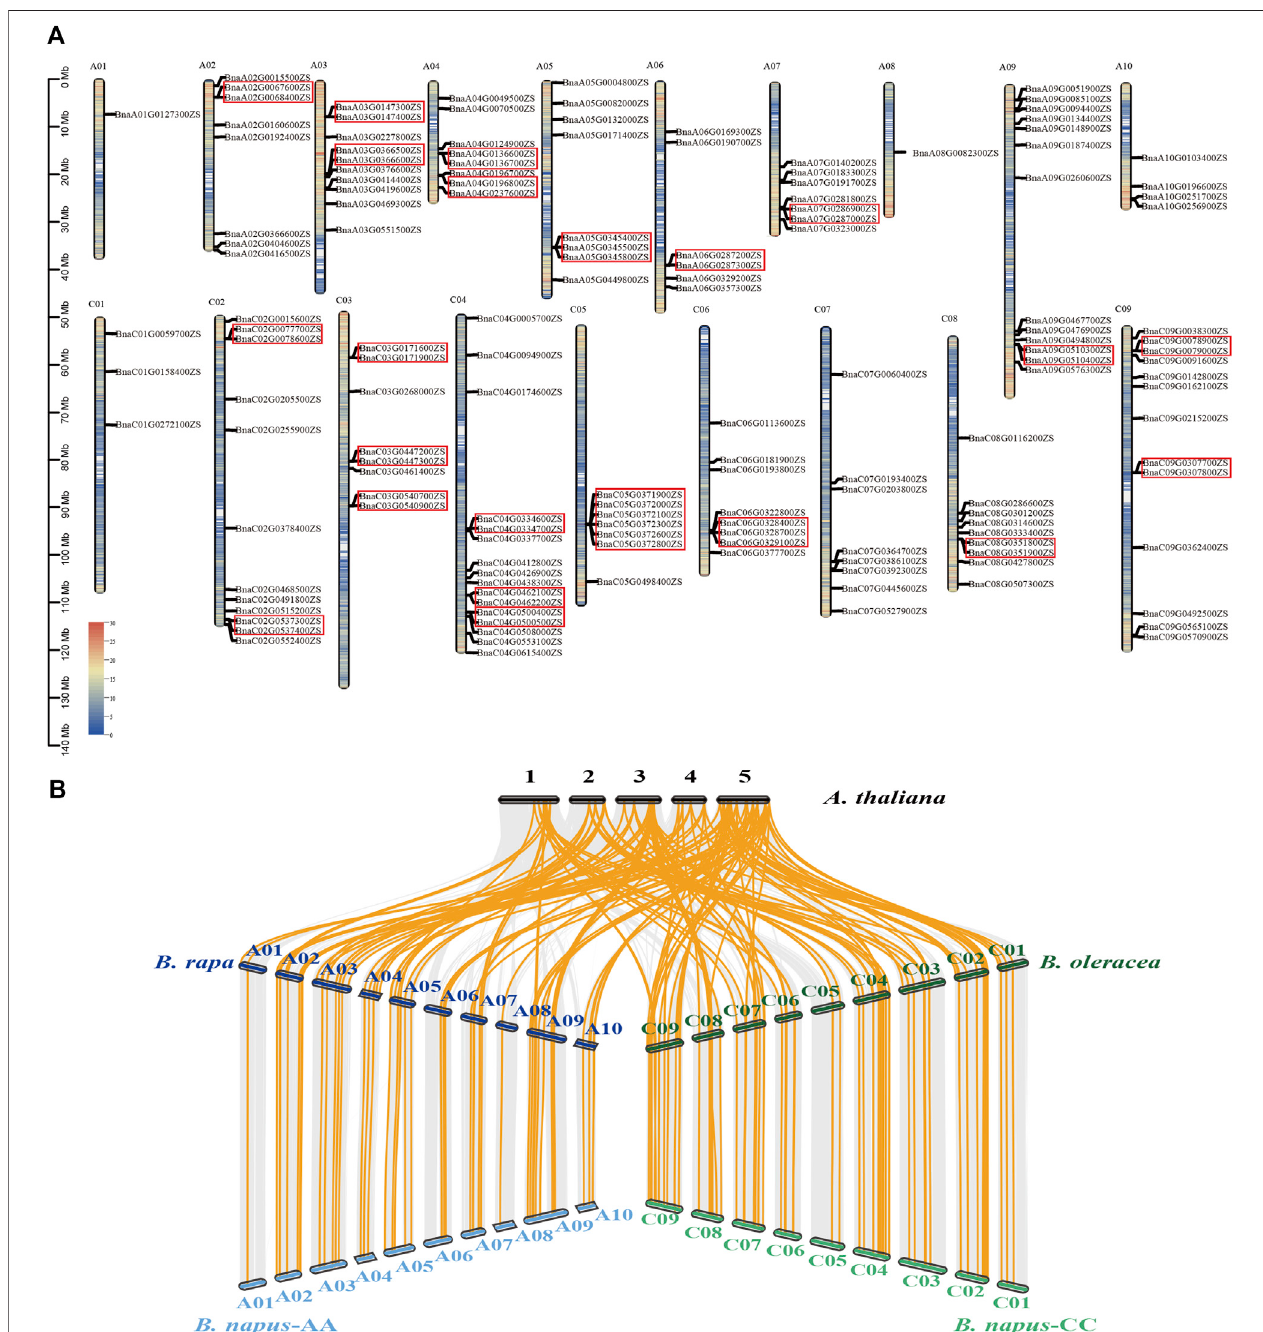
FIGURE 2 | Distribution and syntenic analysis of ABGs in Brassica napus . (A) The color on the chromosome indicates the gene density of all the genes. Redder color indicates the higher gene density, while the bluer color indicates lower gene density. The red boxes indicate tandem duplications. (B) The orange lines indicate the ABGs exhibited syntenic between A. thaliana , B. rapa , B. oleracea , and B. napus .